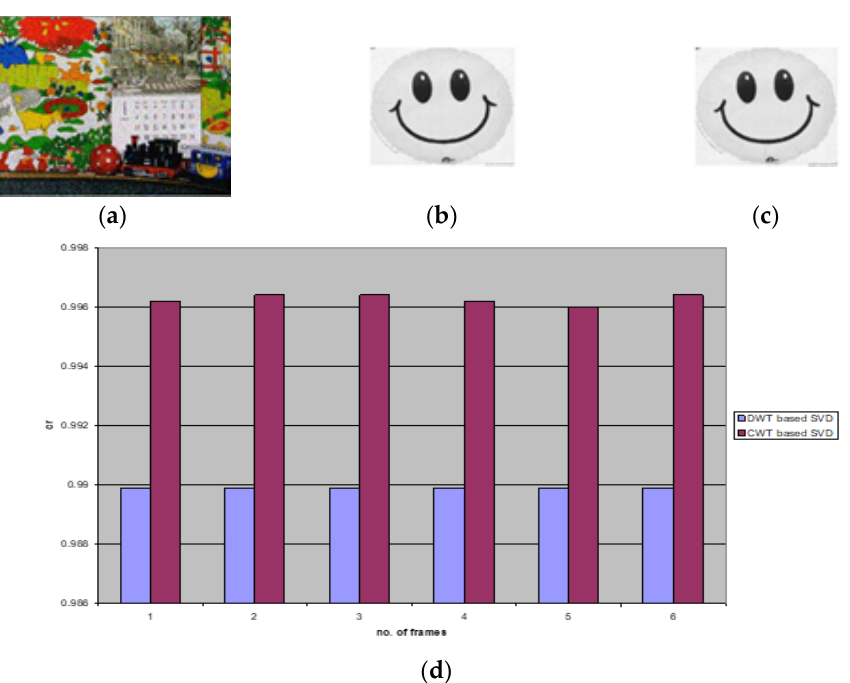
Figure 20. ( a ) The watermarked frame under Gaussian noise attack using the proposed method. ( b ) Extracted watermark from frame 10 of second video in the proposed method. ( c ) Extracted water- mark from frame 10 of the second video scene for the DWT-based SVD method. ( d ) Correlation values for the extracted watermarks from each frame in the second video scene under Gaussian attack with variance 0.01.